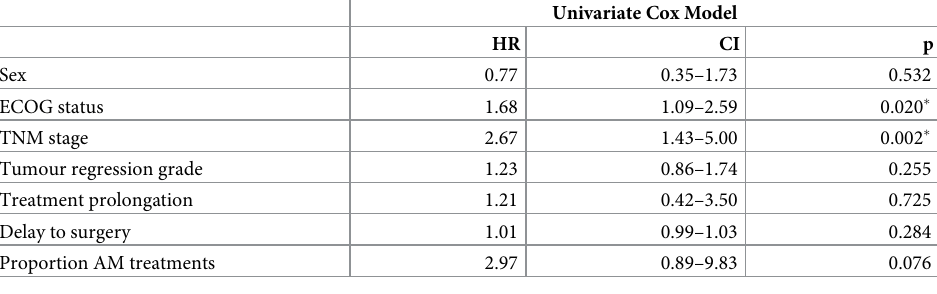
Table 6. Cox proportional hazards model exploring predictors for survival.